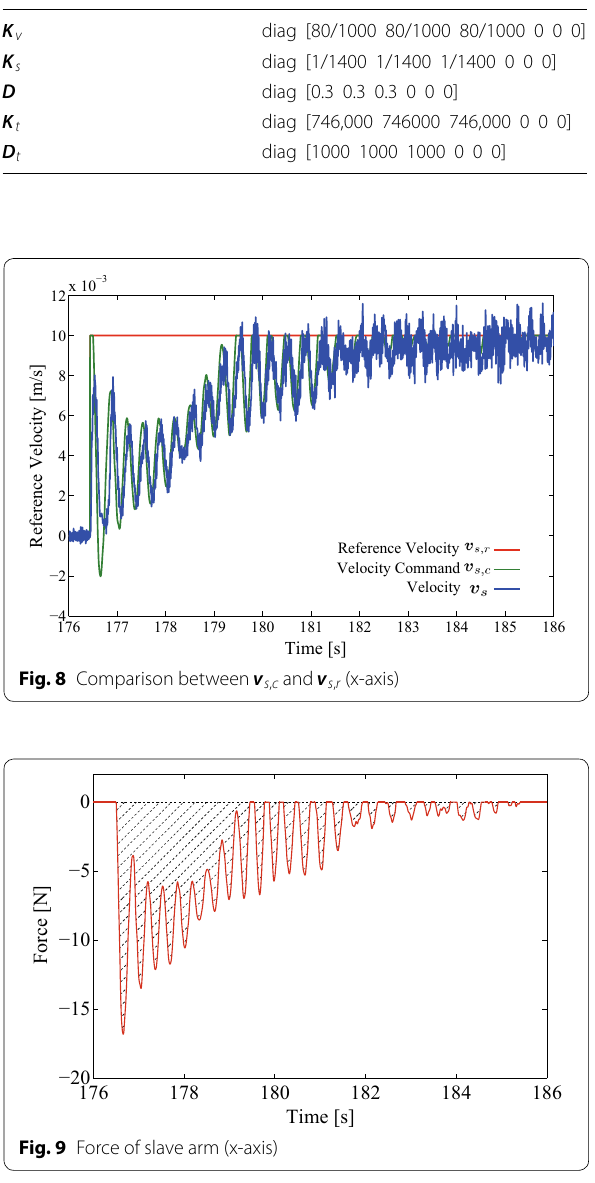
Table 2 Gain parameters of the experiment